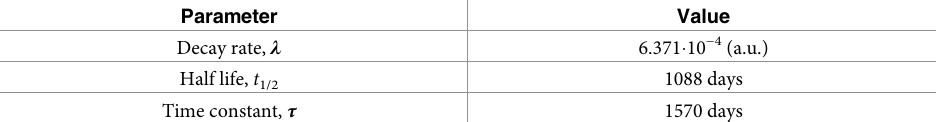
Table 2. Values of the parameters obtained for the mathematical model for the bone mineral density loss for long duration spaceflights.